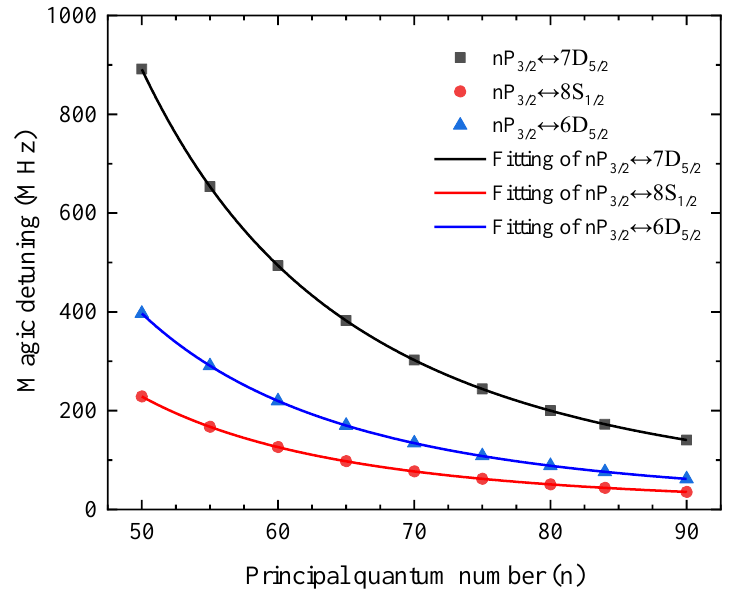
Figure 7. In the vicinity of different auxiliary transitions, the magic detuning at magic angle varies with the principal quantum number from 50 to 90. The solid lines are the fitted results. Table 2. The coefficients a , b , and c of Equation (11) for the auxiliary transitions of nP 3/2 ↔ 7 D 5/2